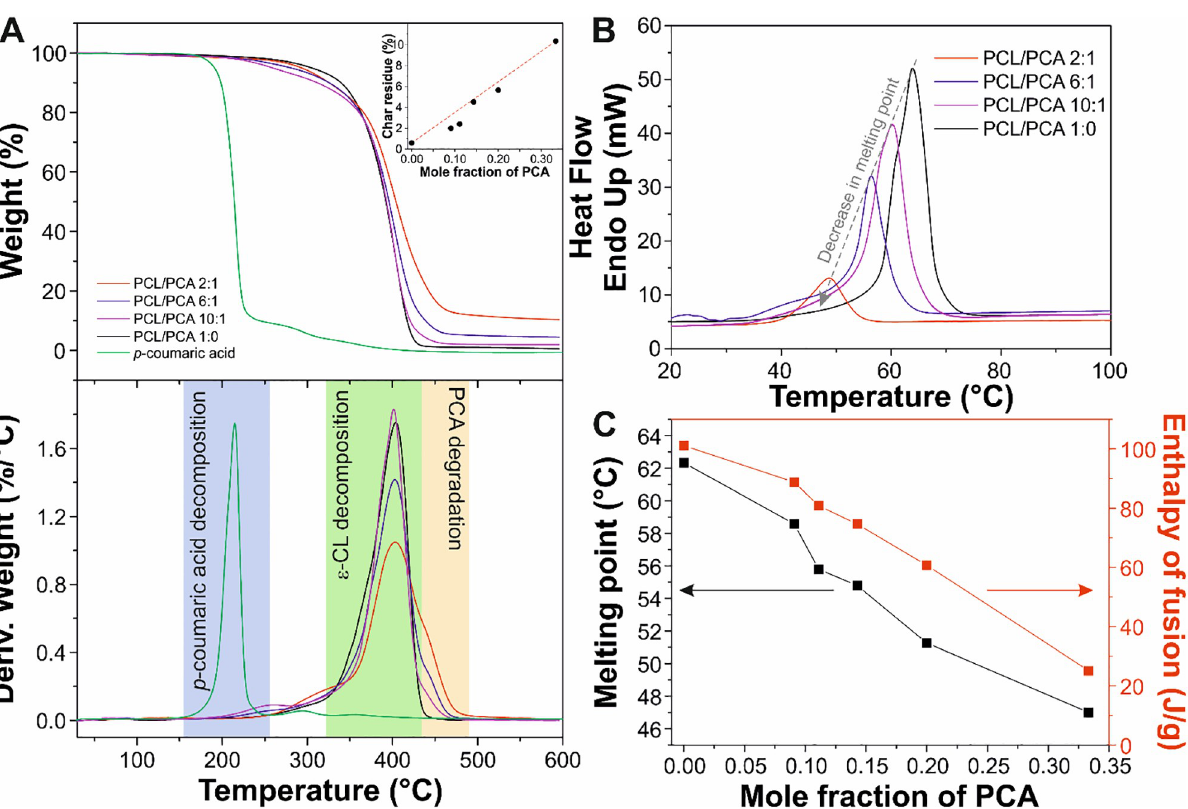
Fig 3. Thermal stability analysis. (A) TGA thermograms (top) and derivative thermogravimetric curves (bottom) of PCL/PCA 1:0, 10:1, 6:1, and 2:1 samples and pure p -coumaric acid. The inset in the top graph shows the percentage of char residue as a function of the mole fraction of PCA. (B) DSC curves of PCL/PCA 1:0, 10:1, 6:1, and 2:1 samples in the range of temperature between 20 and 100˚C. (C) Melting point and enthalpy of fusion of PCL/ PCA copolymers respect to the mole fraction of PCA.